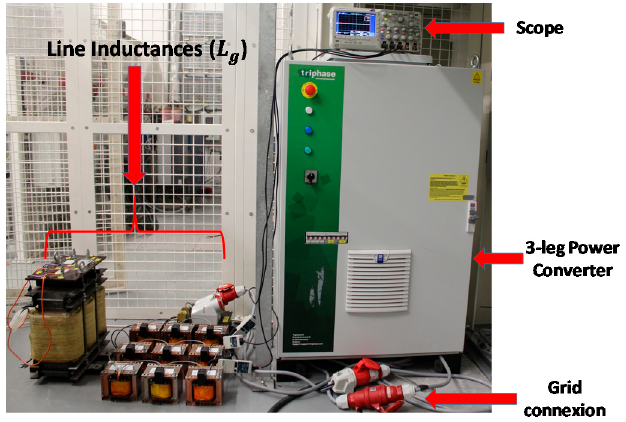
Figure 9. Experimental system.